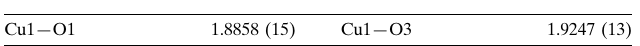
Selected bond lengths (A˚